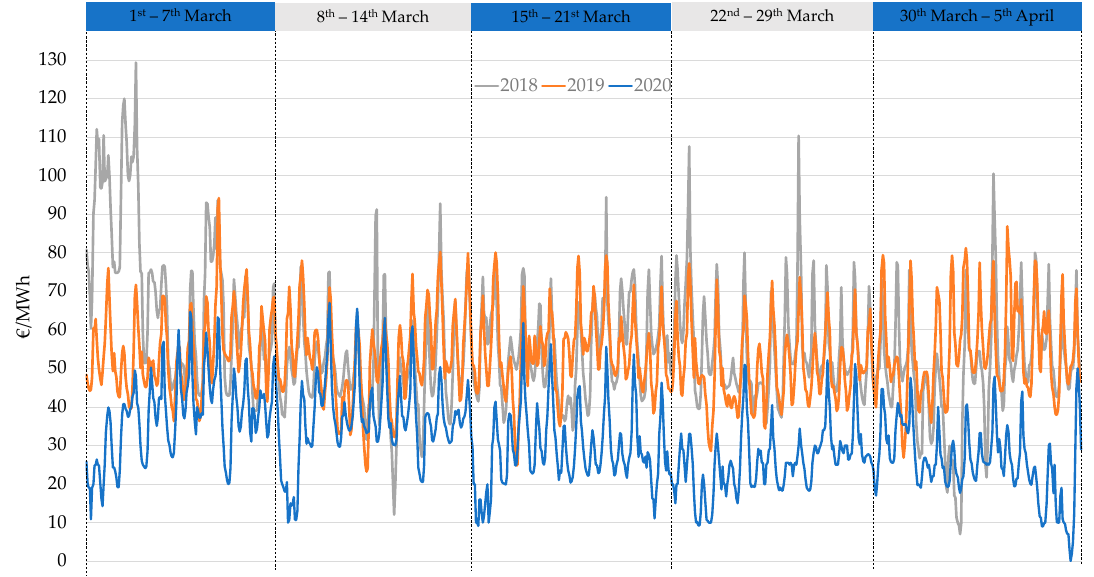
Figure 16. PUN comparison between 2018, 2019 and 2020.